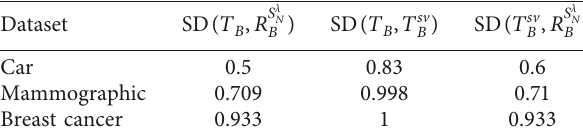
Table 15: Similaritydegrees betweenbinaryrelations T